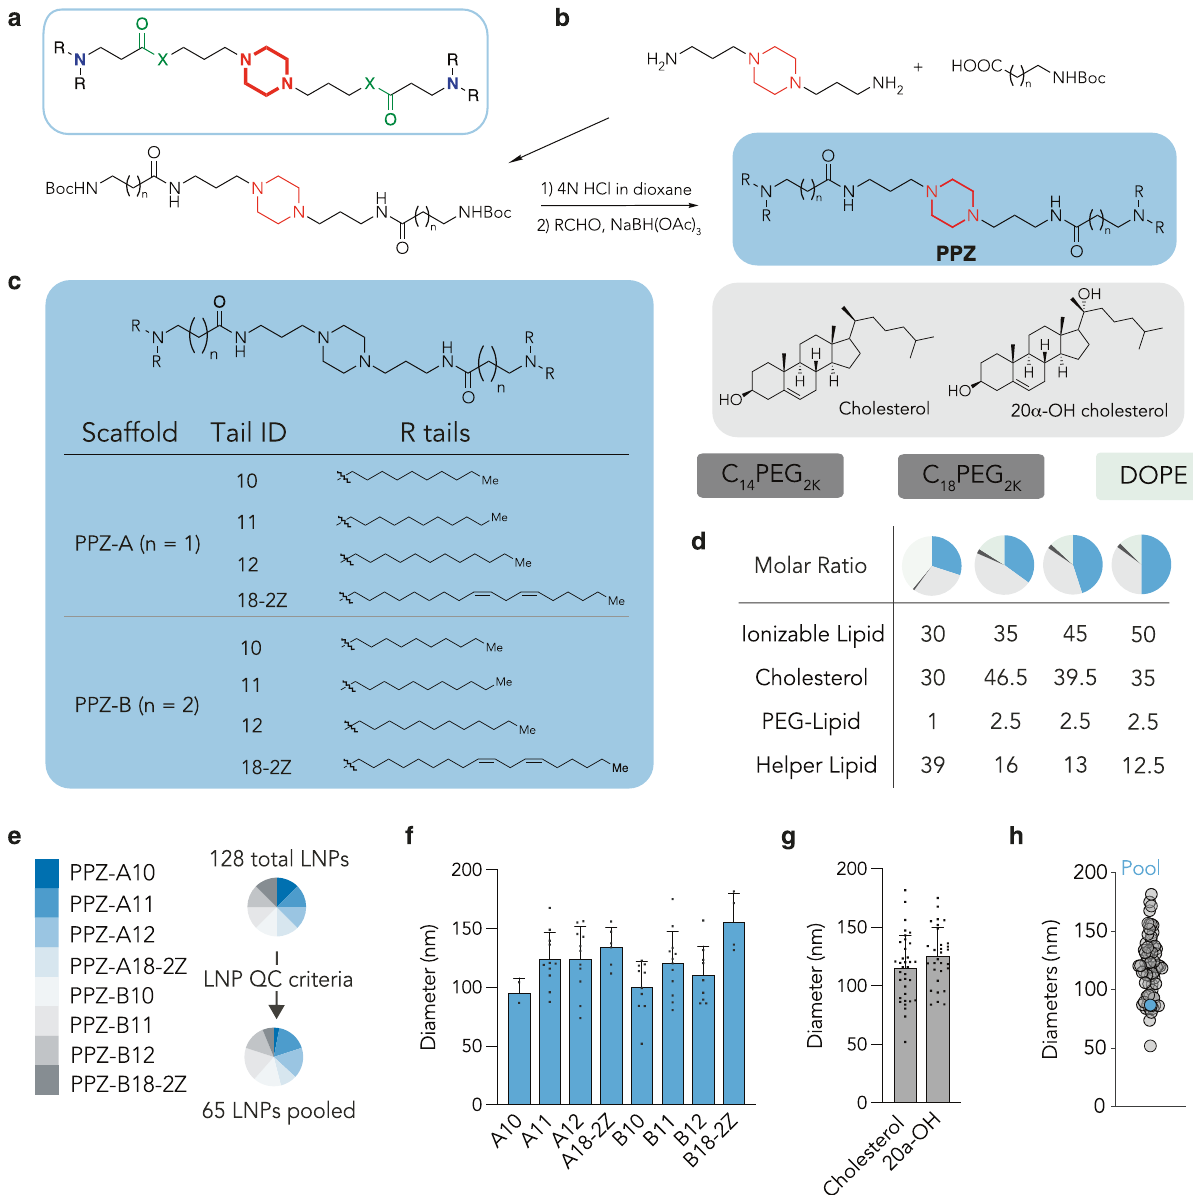
Fig.1|Piperazine-basedlipidsformulateintostablelipidnanoparticles(LNPs). a Design of ionizable lipids with piperazine backbone. b Procedure to synthesize PPZ lipids. c Composition of the LNP library: 8 different PPZ lipids, 2 cholesterol variants (cholesterol and 20 α -OH cholesterol), 2 PEG-lipid variants (C 14 PEG 2K and C 18 PEG 2K ), and DOPE. d Each of the compounds was formulated using four molar ratios. e Of the 128 LNPs that were formulated, 65 passed the quality control